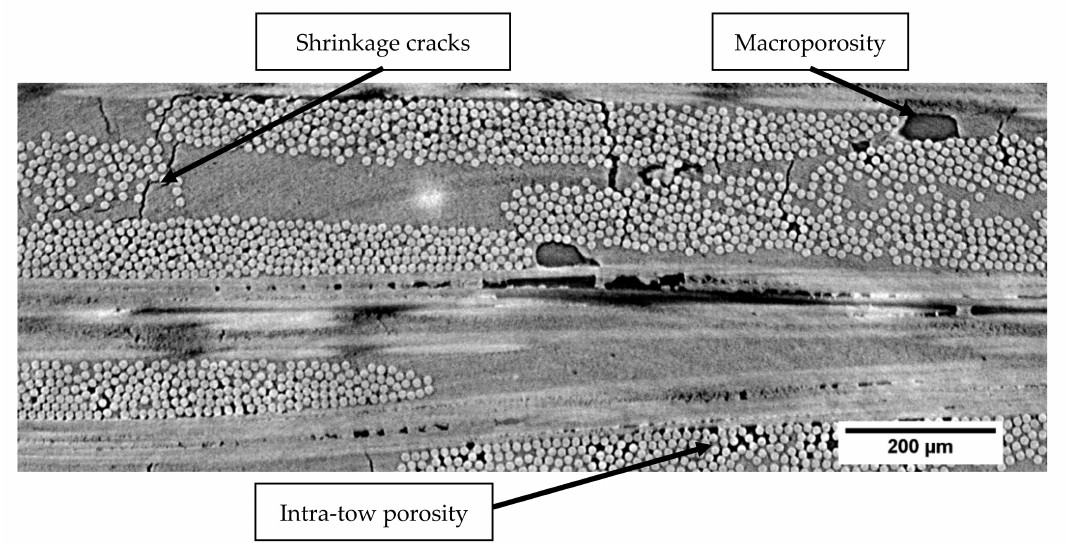
Figure 1. 2D µ -tomographic reconstruction of oxide-based ceramic matrix composite (N610 / Aluminosilicate) at the initial stage. Shrinkage cracks are mainly located in matrix area, and macroporosity is situated between